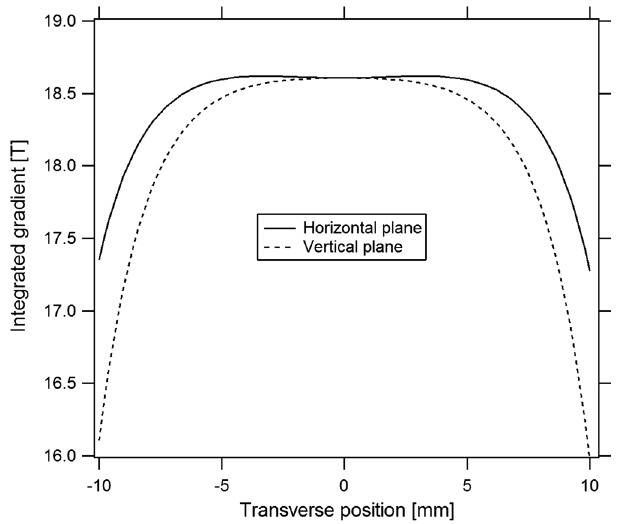
FIG. 5. Integrated gradient simulation, computed with